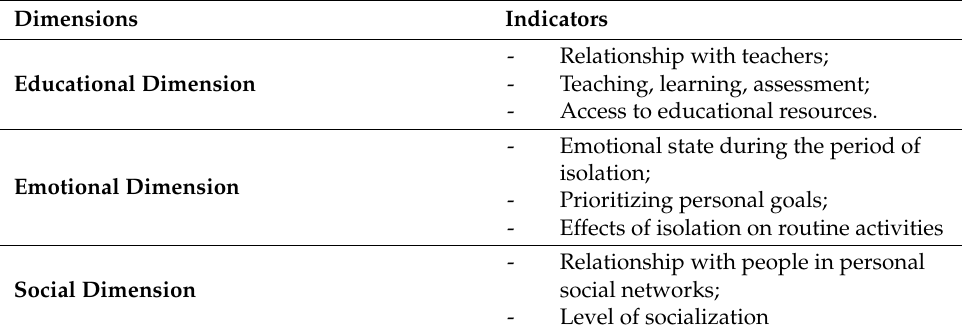
Table 1. Analysis dimensions and